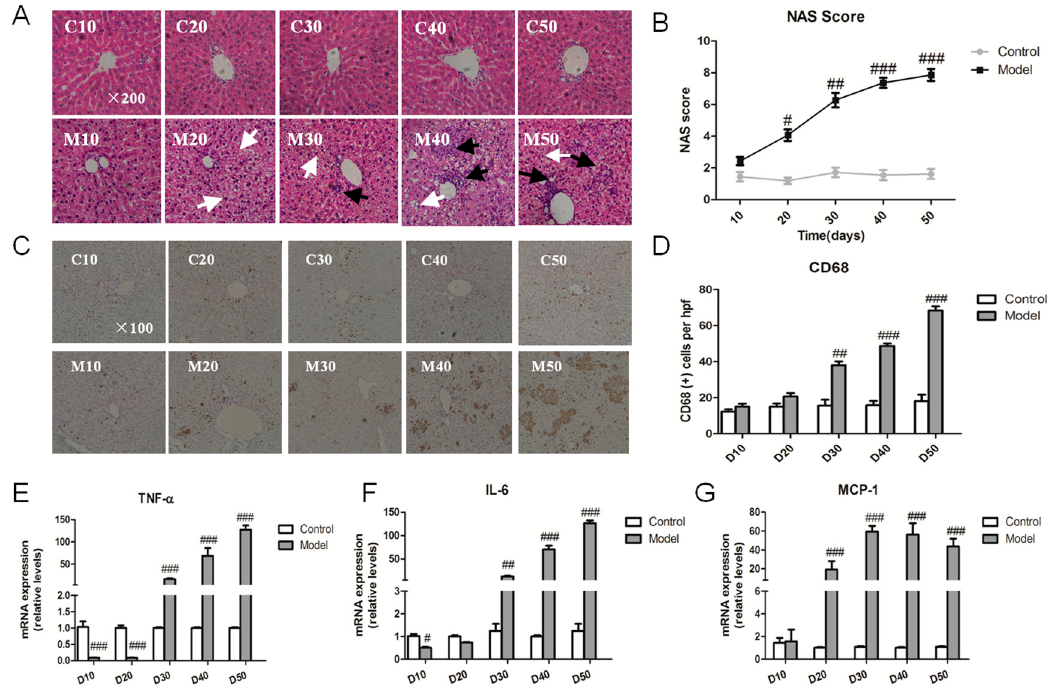
Figure 3. High fat-sucrose diet promoted inflammation development in the liver. The hepatic inflammation change of SD rats induced by a high fat-sucrose diet on day 10, 20, 30, 40, 50. ( A ) Typical hematoxylin–eosin (HE) staining results of each group of rats ( × 200). White and black arrows display fat vacuole of hepatocytes and infiltration of inflammatory cells, respectively; ( B ) NAFLD activity score (NAS) of each group of SD rats after Non-alcoholic steatohepatitis (NASH) induction; ( C ) CD68 positive Kupffer cell ( × 100); ( D ) Semi-quantitative analysis of the CD68 positive Kupffer cell. The relative inflammation factors of the gene TNF- α ( E ), IL-6 ( F ), MCP-1 ( G ) mRNA expression. The values are shown as the means ± SEM ( n = 6). Compared with the corresponding control group, # p < 0.05, ## p < 0.01, ### p < 0.001.